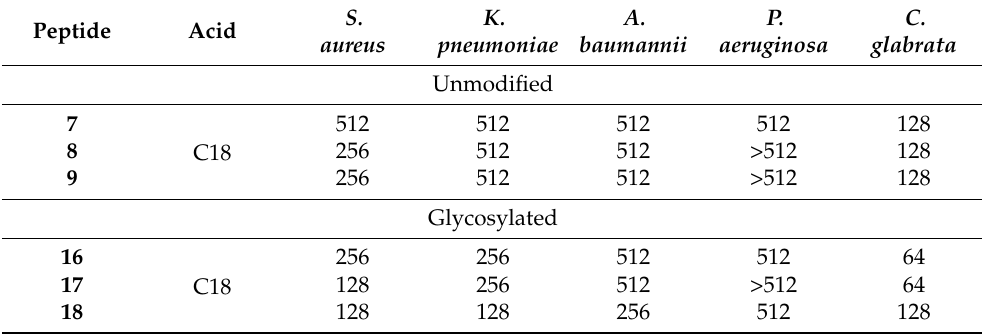
Table 3. Antibiofilm activity (MBEC [ µ g/mL]) of lipopeptides of 7 – 9 and 16 – 18 . Peptide